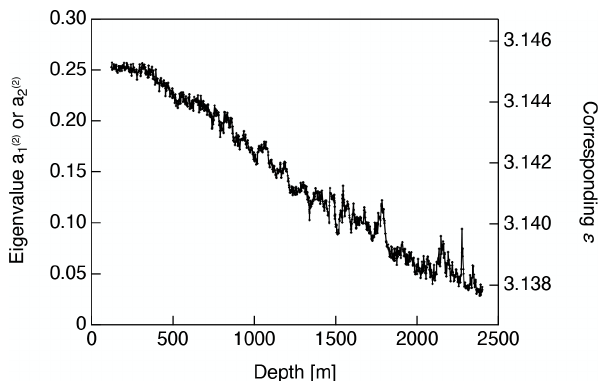
Figure 7. Eigenvalues in the horizontal direction derived from di- electric measurements (i.e., a ( 2 ) or a ( 2 ) in Fig. 5b). The right-side 1 2 y axis is the permittivity corresponding to the eigenvalue on the left- side y axis. See Saruya et al. (2022) for the relationship between the normalized eigenvalues and